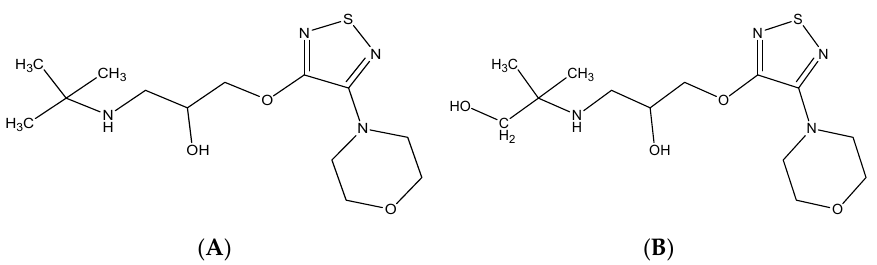
Figure 6. Chemical structures of timolol and hydroxytimolol, ( A ) Timolol, Theoretical m / z 317.16419 ( B ) Hydroxytimolol, Theoretical m / z 333.15910. Table 1. Formula, ionization mode, theoretical mass, measured mass, mass accuracy and MS 2 data for 27 β